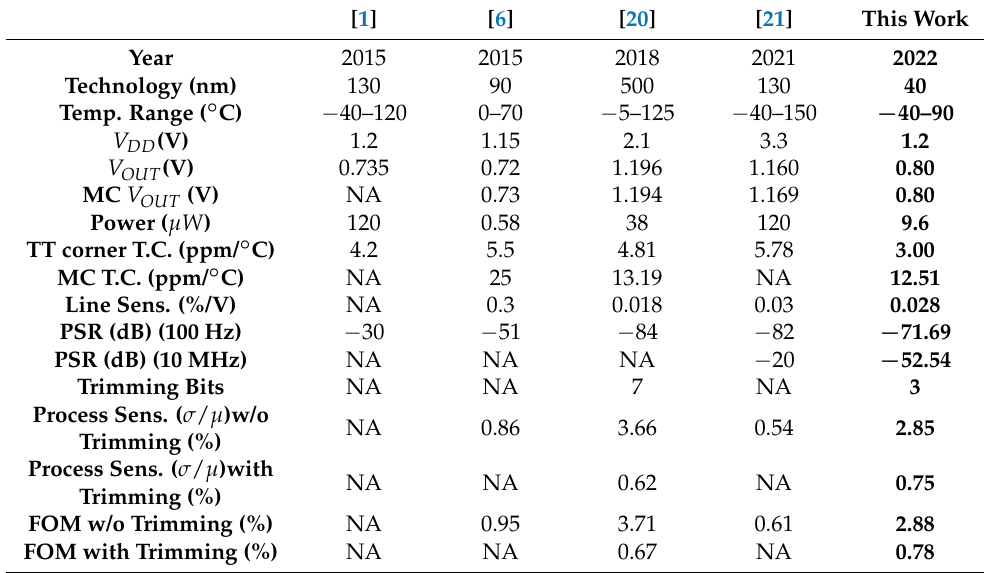
Table 5. The Performance Benchmarks Against Voltage Reference with Parasitic